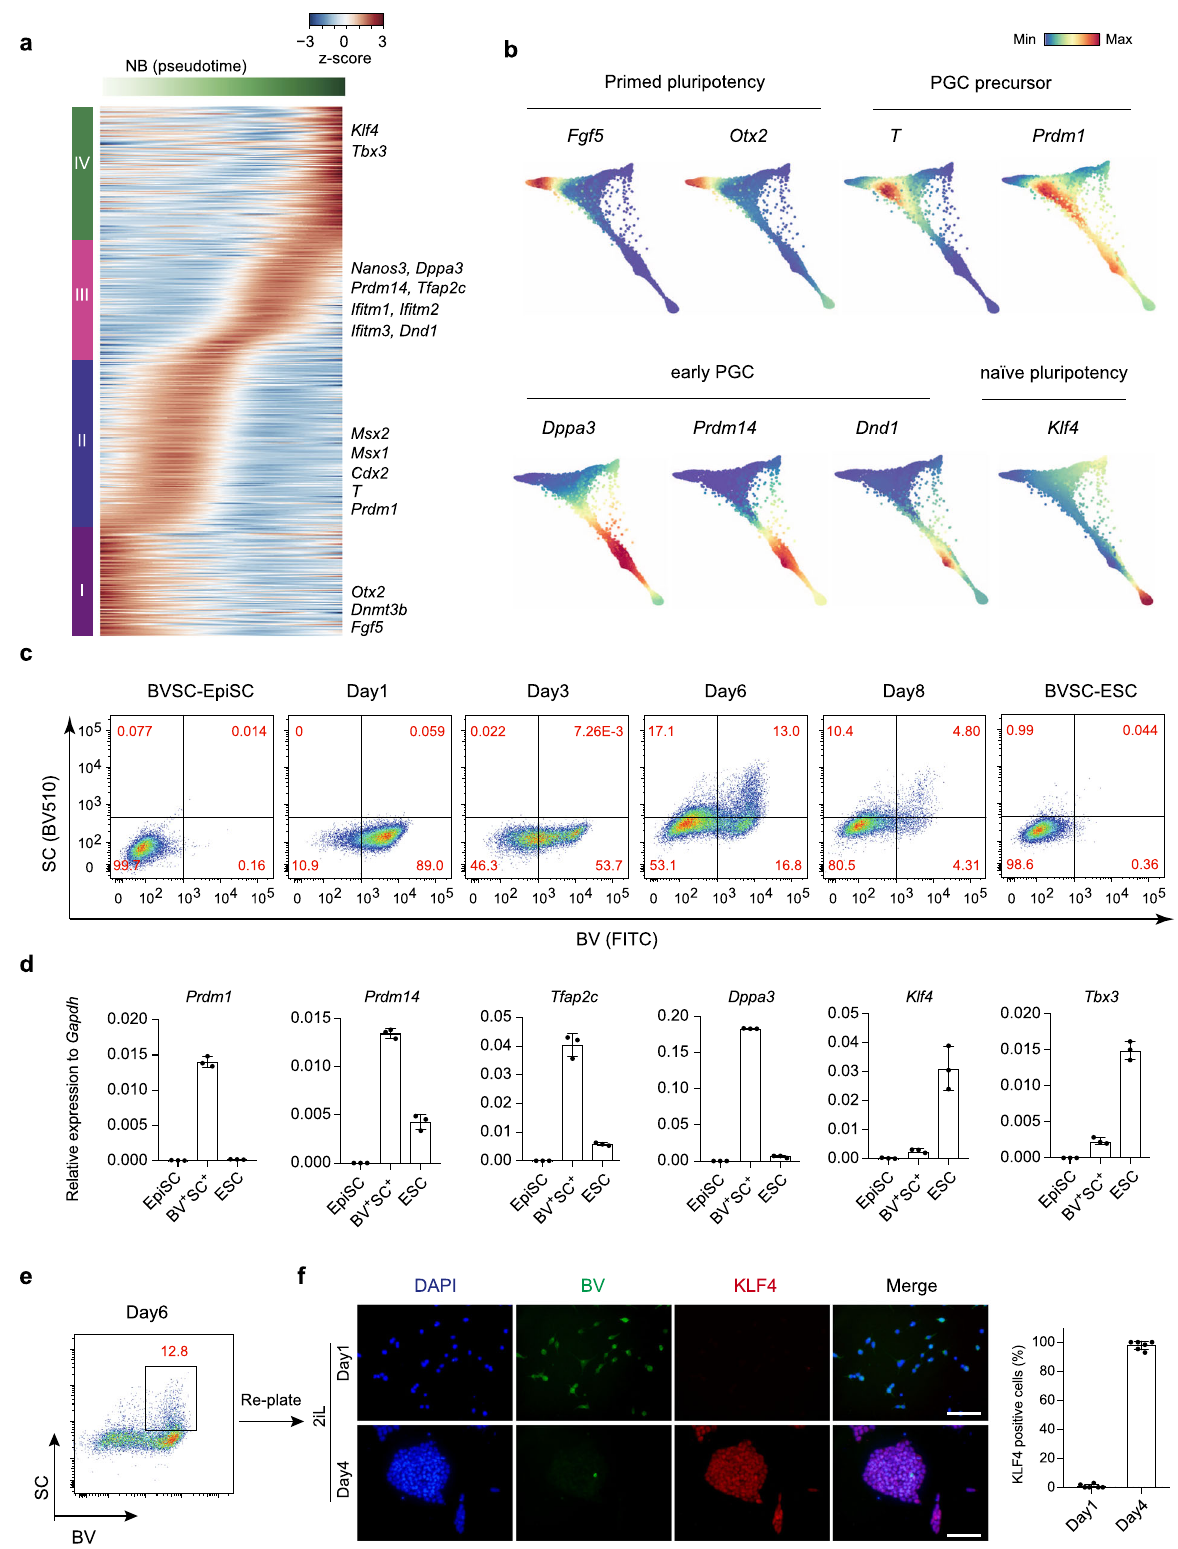
Fig. 3 Activation of PGC-like program during successful BiPNT. a Gene expression heatmap of 3219 dynamic expressed genes along NB (naïve branch) in a pseudotemporal order. Representative genes are shown on the right. b Plots showing the expression patterns of the indicated genes during BiPNT. c FACS analysis of BVSC induction at distinct time points during BiPNT. d RT-qPCR analysis for expression of indicated genes in EpiSC, BV + SC + cells from Day 6 of BiPNT and ESC. Data are mean ± s.d., n = 3 independent experiments. e BV + SC + cells were sorted from Day 6 of BiPNT as c . f Left: BV + SC + cells from e were re-plated with 2iL medium for further transition into naïve state. Immunostaining for KLF4 to monitor the transition process. Scale bars, 100 μ m. Right: Percentage of KLF4 positive cells. Data are mean ± s.d., n = 6 microscope fi elds. Source data are provided as a Source Data fi